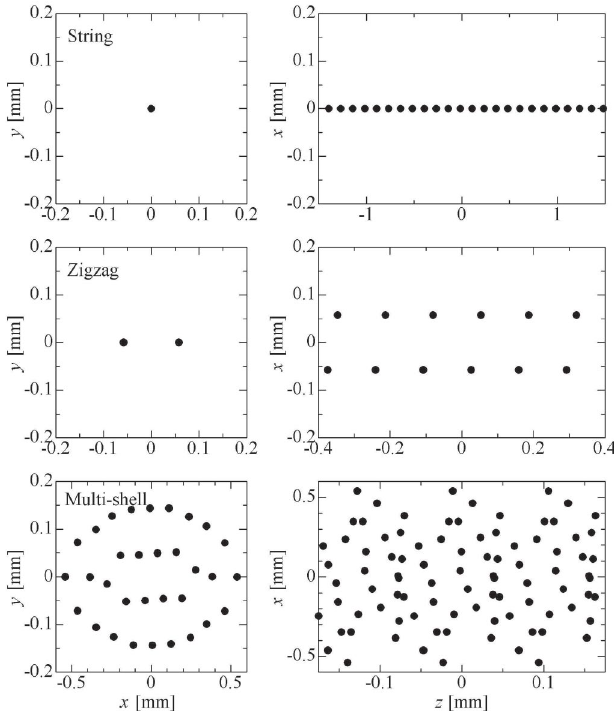
FIG. 1. Real-space configurations of typical coasting crystal- line beams. The horizontal and vertical bare betatron phase advances per lattice period have been both set at 86.6 degrees in all three examples. Each dot ( (cid:7) ) in the pictures corresponds to a single 24 Mg (cid:4) ion circulating in S-LSR at the kinetic energy of 35 keV. The symbols (cid:3) x; y; z (cid:5) represent, respectively, the horizontal, vertical, and longitudinal spatial coordinates in the beam rest frame. At very low line density, a one-dimensional (1D) string crystalline structure is formed (upper panel). By increasing N , we can transform a string into a two-dimensional (2D) zigzag crystal (middle panel) and, then, eventually attain a 3D shell crystal (lower panel). These ordered structures are stable without dissipation.